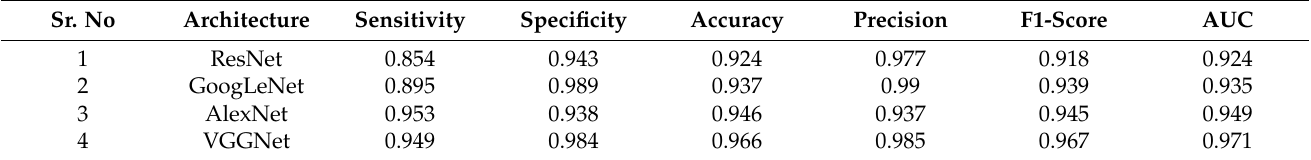
Table 5. The performance comparison of the proposed model on an original and augmented